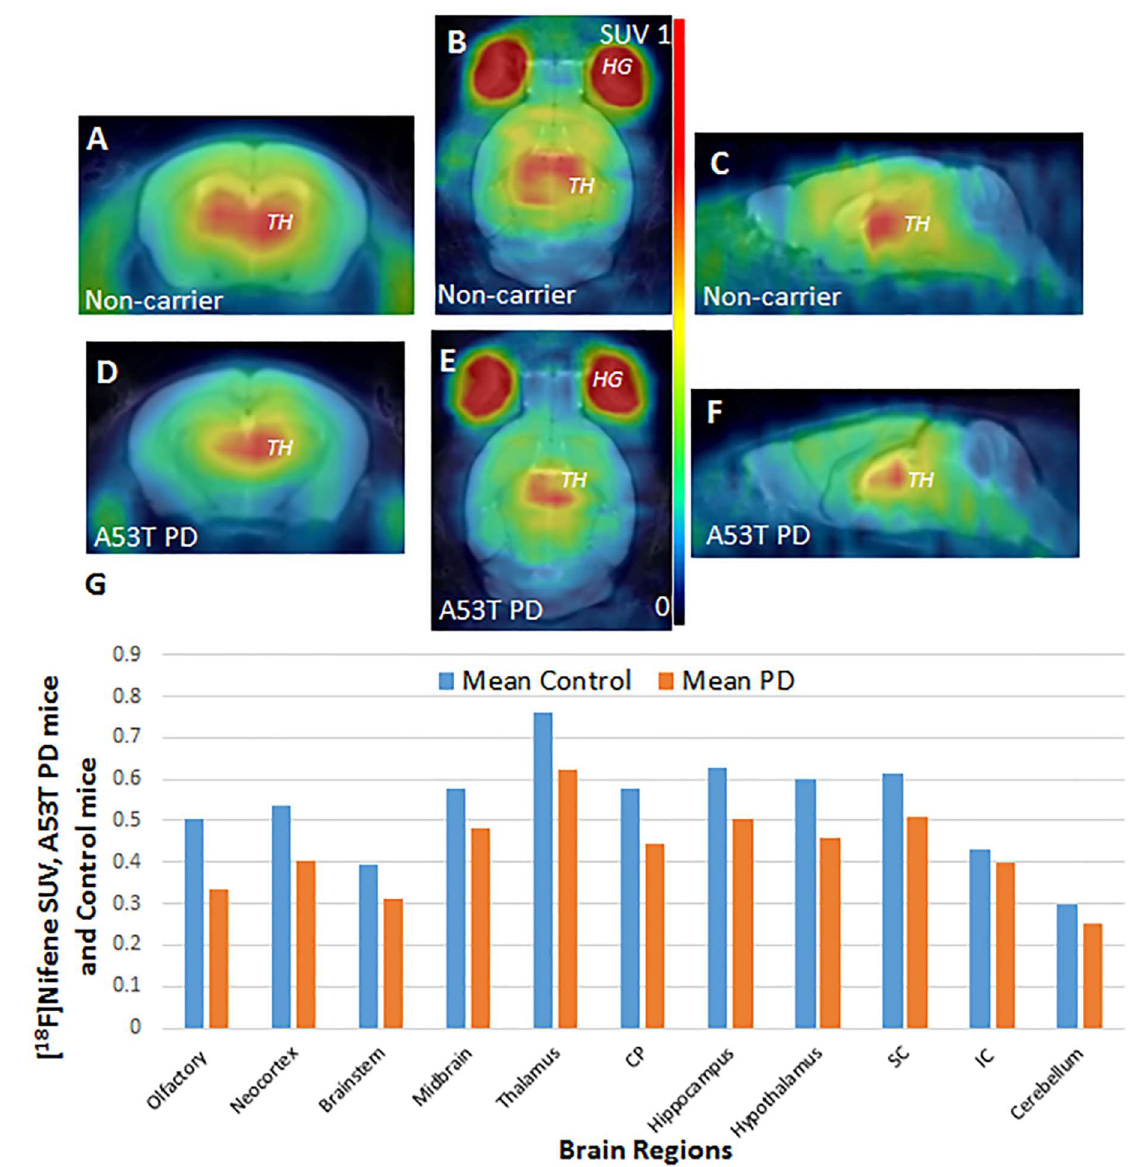
Figure 7. Hualpha-Syn ((A53T) PD mice brain PET-MR of [ 18 F]nifene. ( A – C ): [ 18 F]Nifene PET co-registered to mouse MR template non-carrier mice; ( D – F ): [ 18 F]Nifene PET co-registered to mouse MR template Hualpha-Syn ((A53T) PD mice; ( G ): Plot of [ 18 F]nifene SUV of Hualpha-Syn ((A53T) PD mice versus non-carrier mice in different brain regions (n = 4 WT and n = 4 TG). CP = caudate putamen; SC = superior colliculus; IC = inferior colliculus ( p < 0.05 for all regions except brain stem, midbrain, and hippocampus, SC, IC, and cerebellum were not significant).